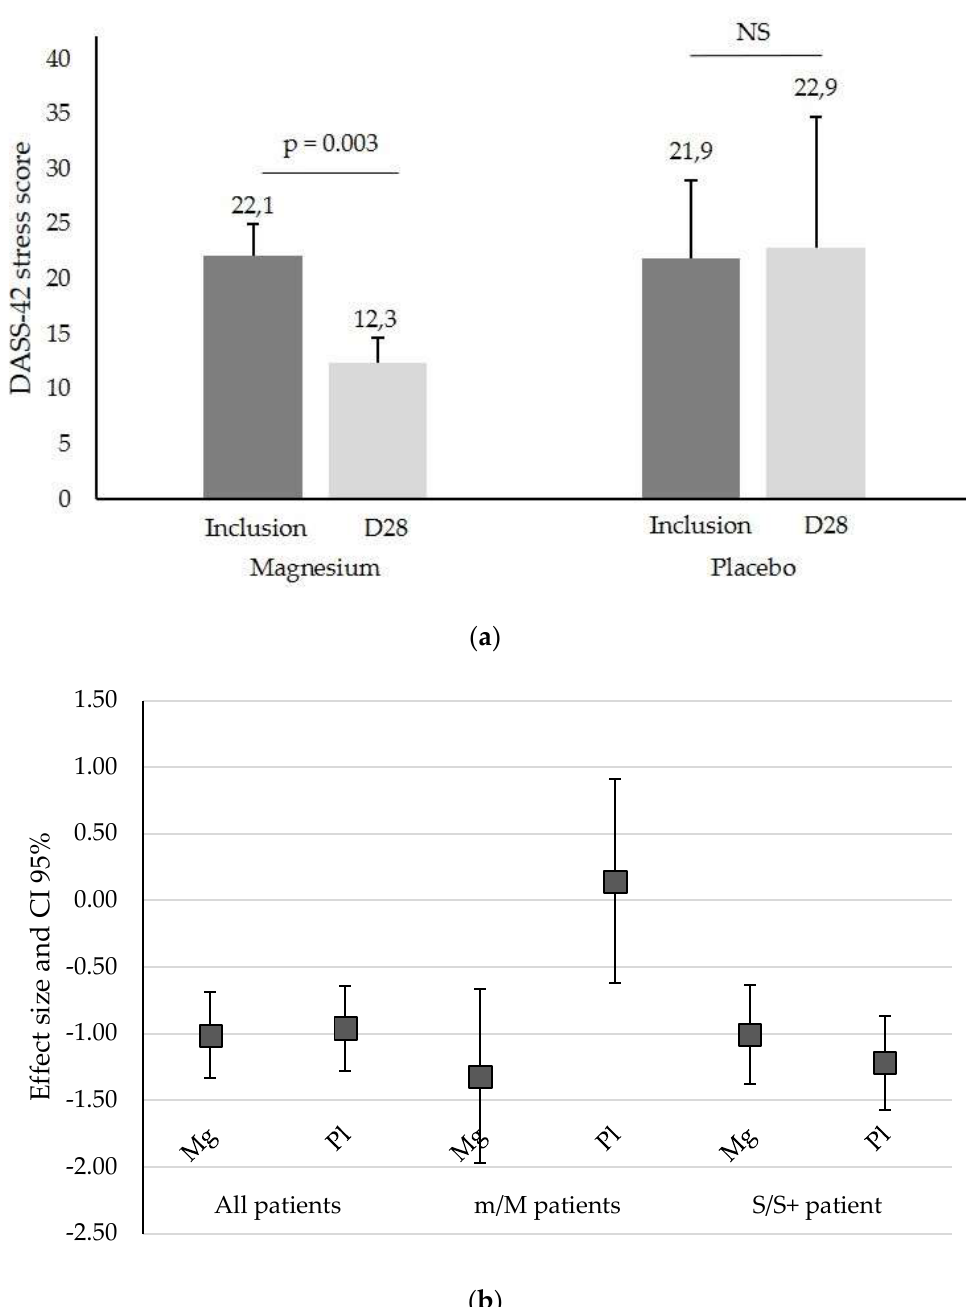
Figure 2. ( a ) DASS-42 stress score (mean ± sd) in patients with a mild/moderate (m/M) stress score at inclusion and after one month of Mg or placebo treatment (D28), NS, not significant. ( b ) DASS-42 stress effect size of Mg and placebo (Pl) for all patients, mild/moderate (m/M) patients, and severe/extremely severe (S/S+) stress at inclusion. The squares represent the effect size (variation in the DASS-42 value) and the whiskers represent its 95% CI limits.